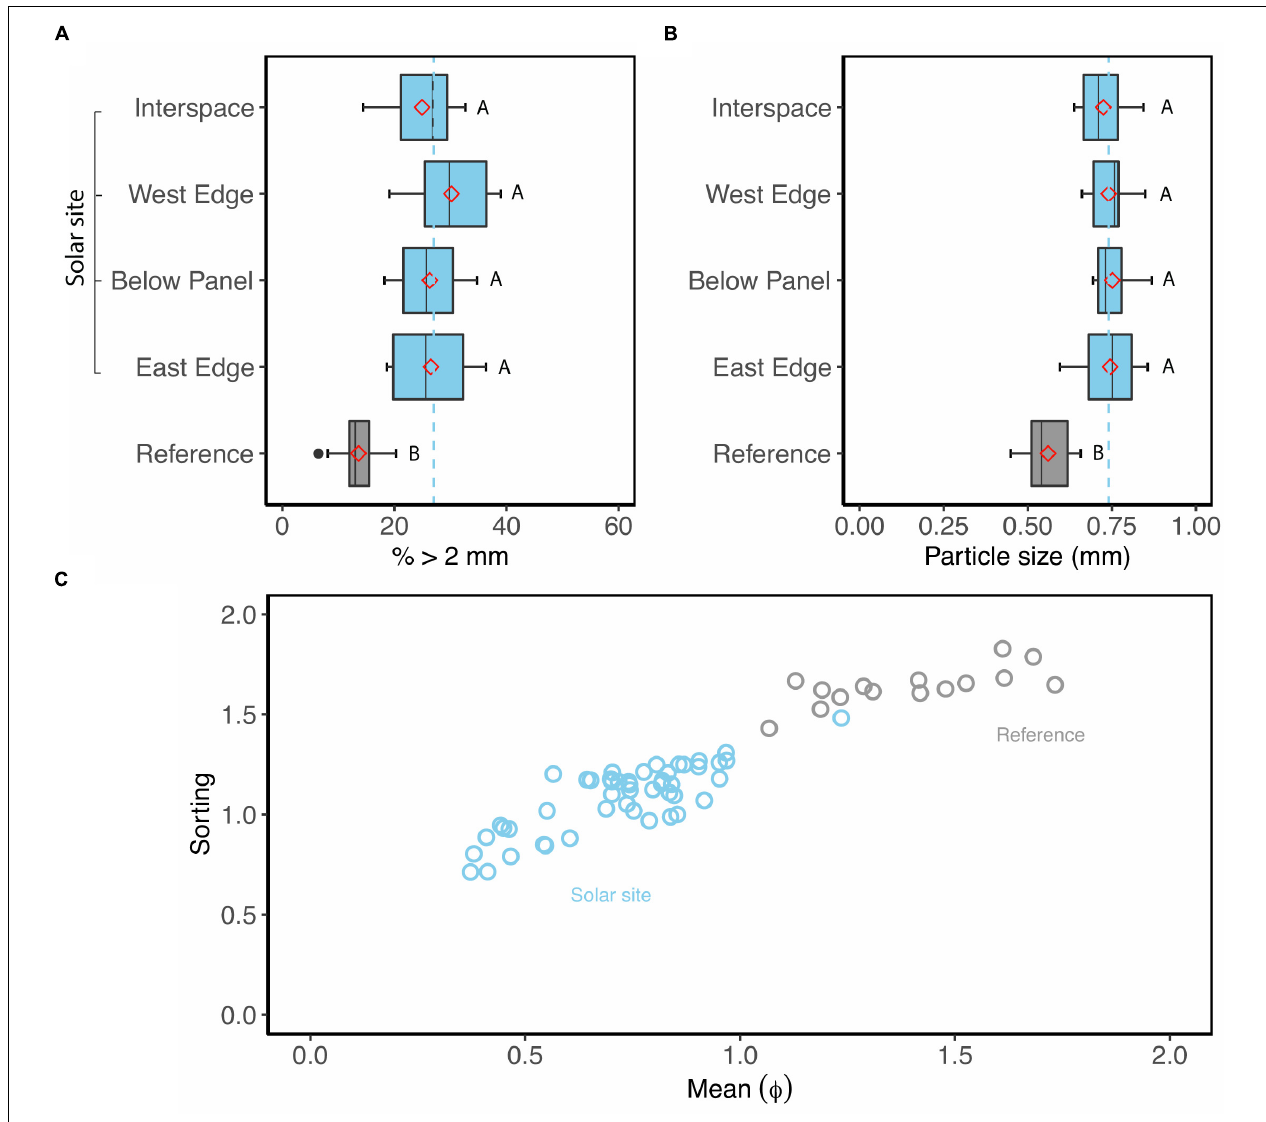
FIGURE 2 | (A) Percentage of grain diameter larger than 2 mm and (B) the mean particle diameter ( < 2 mm) of the soil samples from control and solar site. (C) Sorting and mean of soil particle size ( ϕ size scale) for control and solar site. See Figure 1 for an explanation of plot structure and abbreviations.